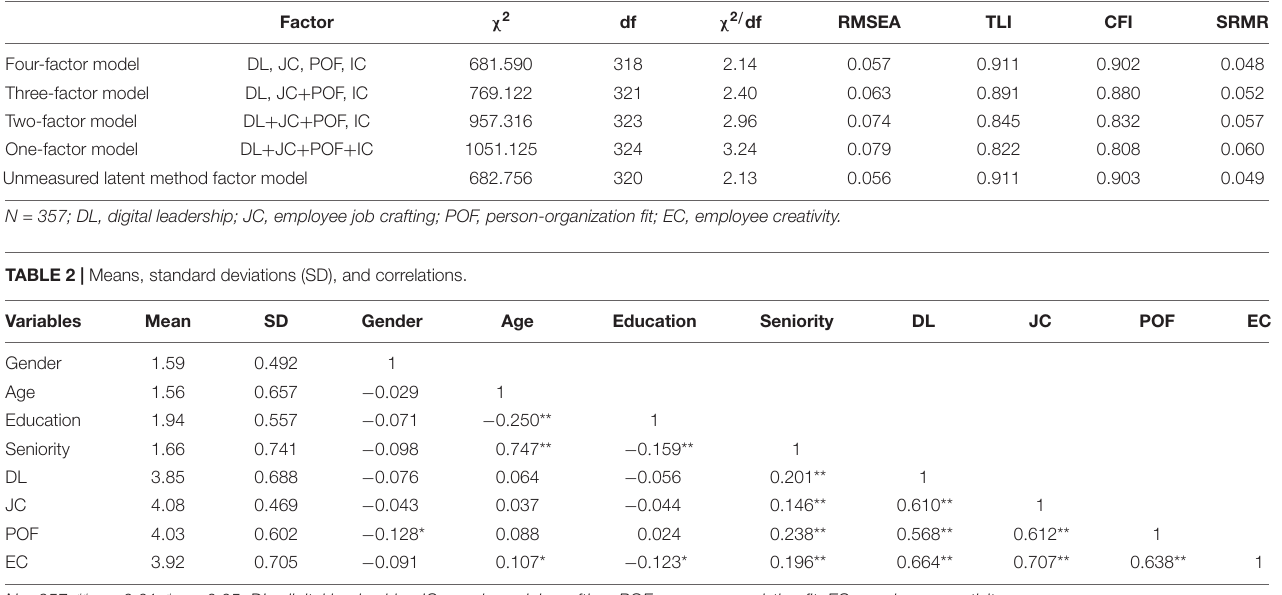
TABLE 1 | Results of confirmatory factor analysis.